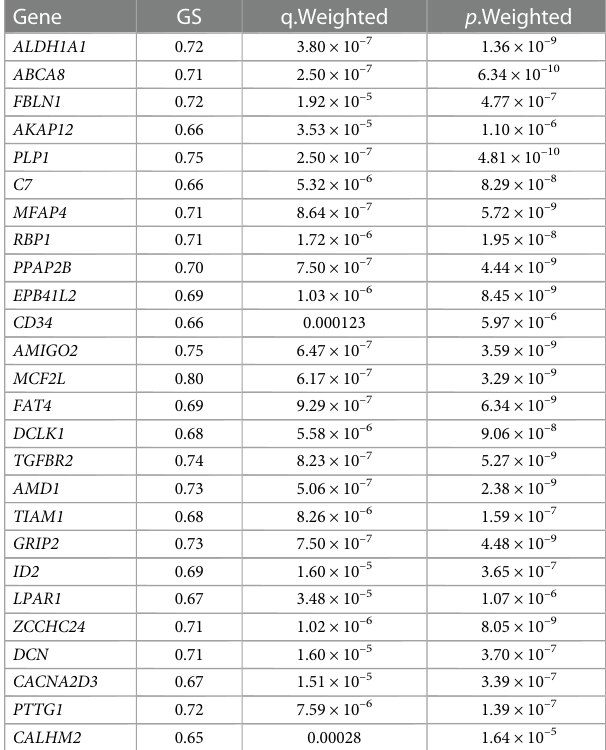
TABLE 2 Hub genes screened in the pink